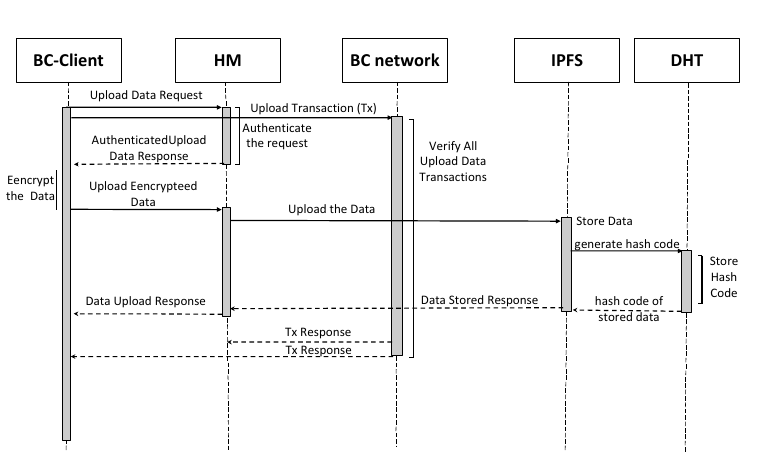
Figure 5. The Sequence Diagram of Activities of the Proposed Method.